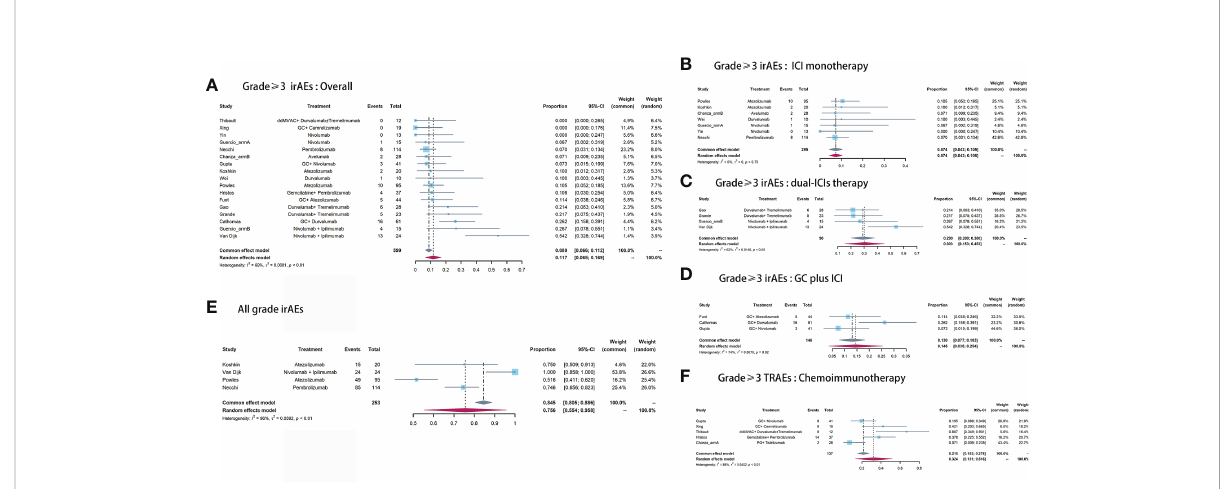
FIGURE 4 Pooled Grade ≥ 3 irAEs rate of (A) overall, (B) ICI monotherapy, (C) dual-ICIs therapy, (D) GC plus ICI therapy. (E) Pooled all grade irAEs rate. (F) Pooled Grade ≥ 3 TRAEs rate of